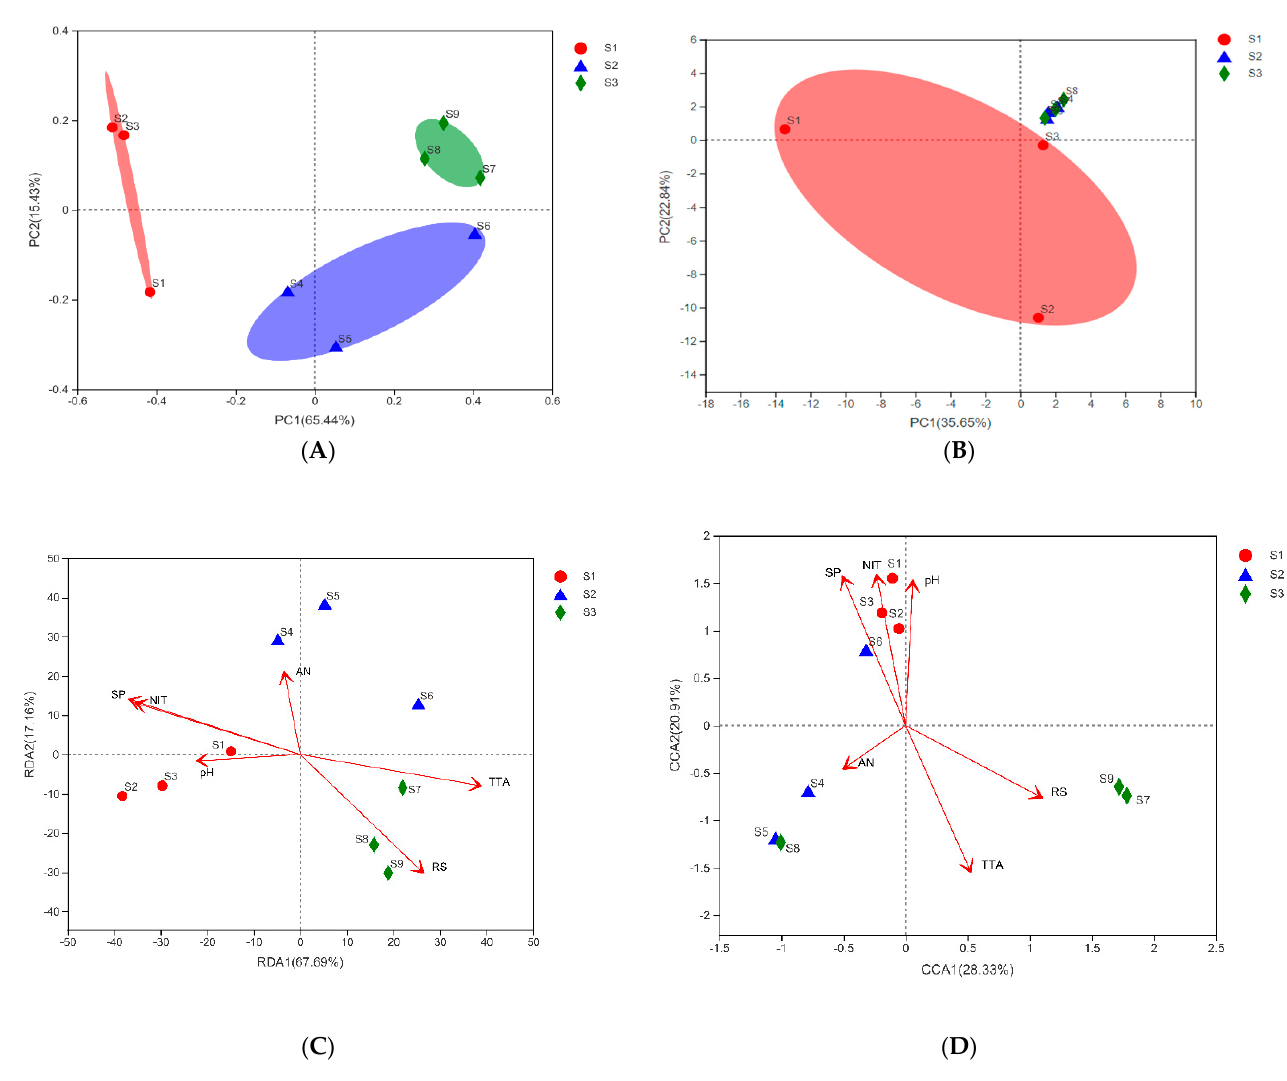
Figure 4. The PCoA of bacteria samples ( A ); the PCA of fungi ( B ) at different fermentation stages. RDA between physicochemical factors and bacteria ( C ); CCA between physicochemical factors and fungi ( D ) in paocai fermentation. fungi ( D ) in paocai